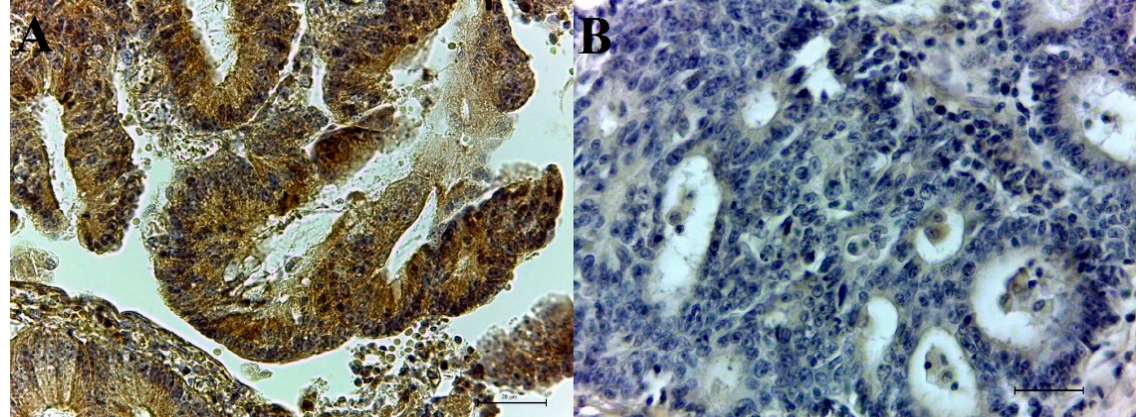
Figure 2. Immunohistochemical detection of survivin with DAB staining: ( A ) survivin-positive colorectal adenocarcinoma (high magnification), ( B ) survivin-negative colorectal adenocarcinoma (high magnification). Table 2. CAIX and survivin expression in colorectal adenocarcinomas (number and percentage of specimens). Quantity of CAIX Expression No./%